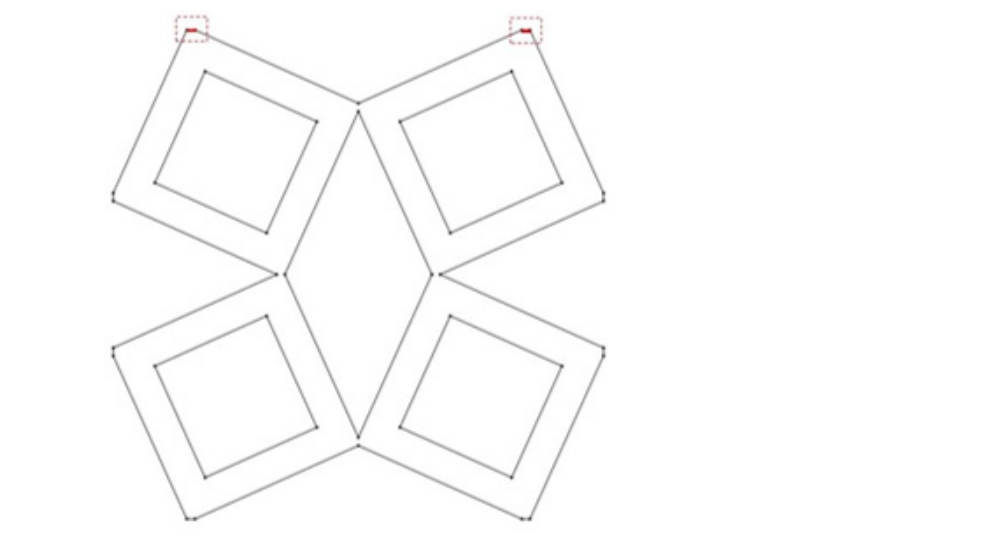
Figure 11. The edges constraint using roller boundary condition.